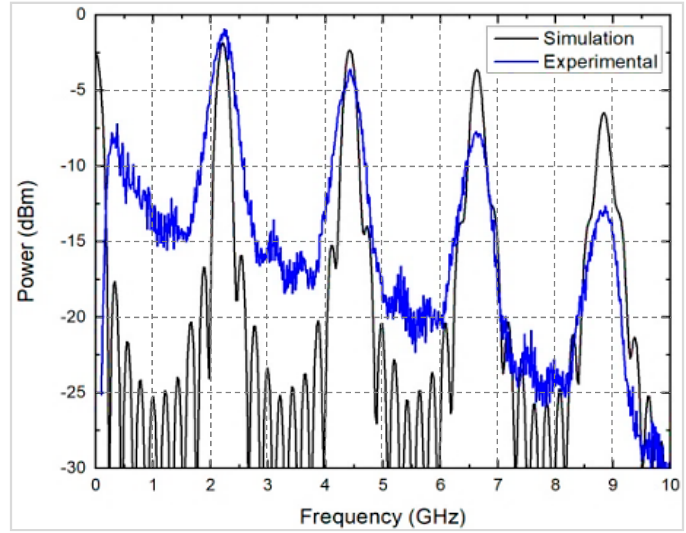
Figure 2. Frequency response of the microwave photonic filter.